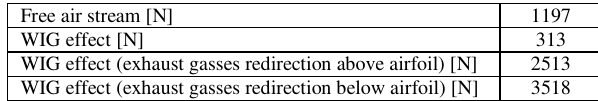
Table 3. Drag force values for NACA M8 profile